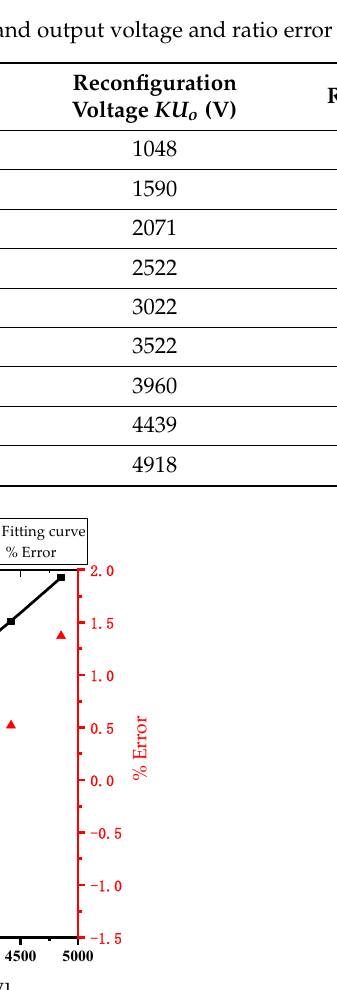
Table 4. High-voltage performance test input and output voltage and ratio error calculation results.